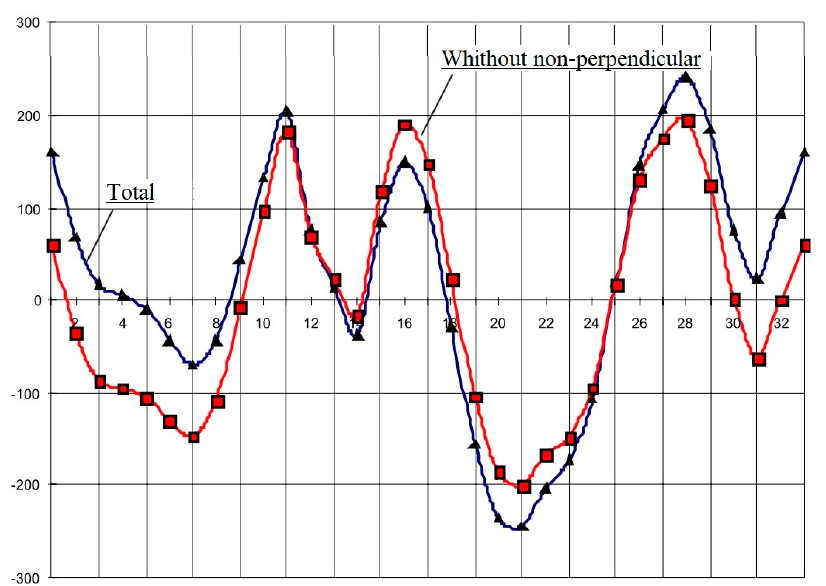
Figure 2. Harmonic components of vibrations of the thrust bearing disc due to beating.